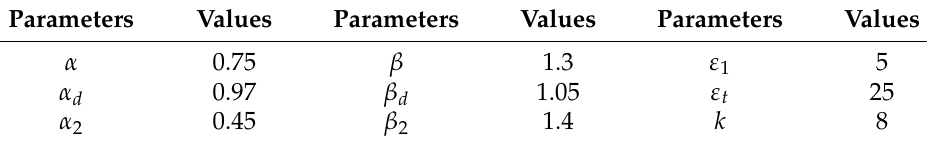
Table 3. Experimental parameters settings of moving target detection algorithm. Parameters